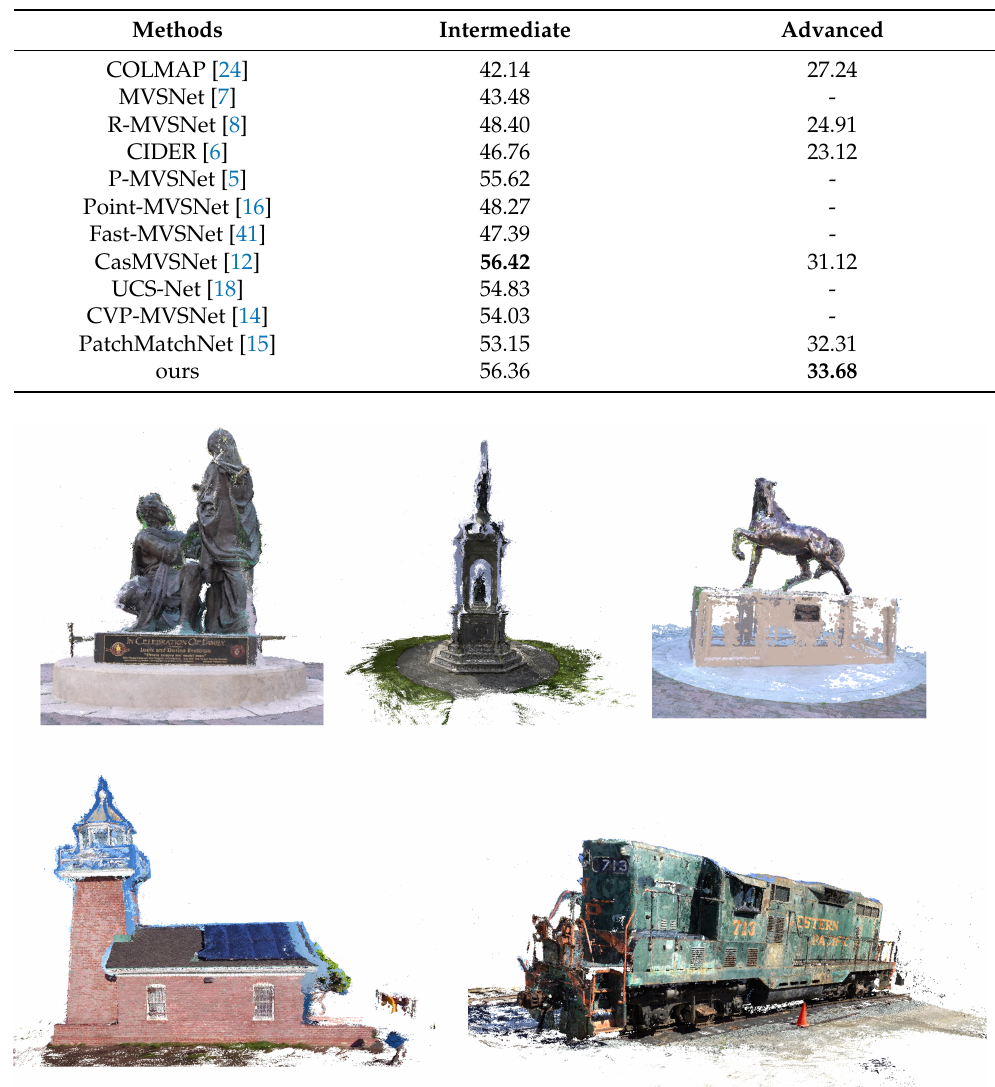
Figure 5. Reconstruction results on the Tanks and Temples dataset